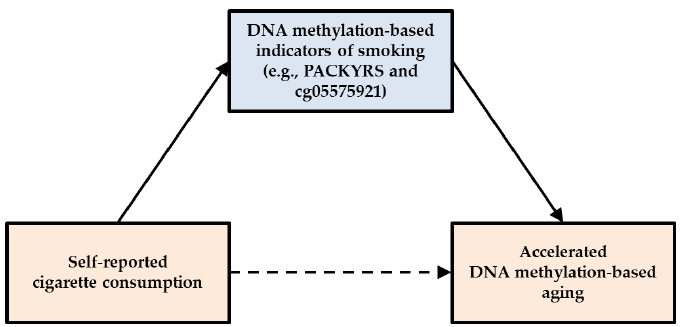
Figure 1. Theoretical model linking self-reported cigarette consumption to accelerated aging outcomes through DNA methylation-based indicators of smoking.